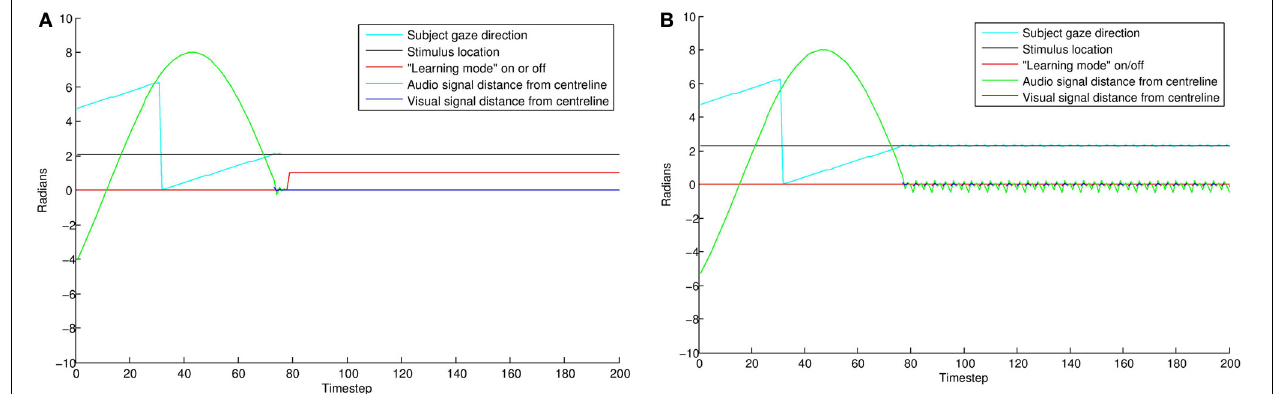
FIGURE 9 | Comparing individual simulations with “direct gaze” (A) and “averted gaze” (B) by 0.08 radians. With a direct gaze stimulus, the subject (cyan line) finds the stimulus (black line) and quickly aligns until error is zero. It then goes into learning mode (red line) for the rest of the trial. With the averted gaze stimulus, the subject finds the